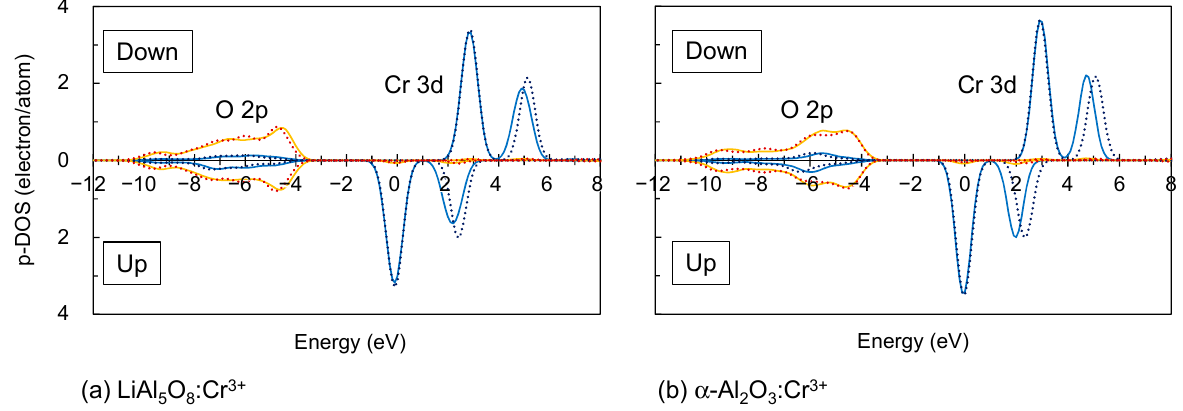
Figure 2. Partial density of states of Cr 3d and O 2p orbitals in ( a ) LiAl 5 O 8 :Cr 3+ and ( b ) α -Al 2 O 3 :Cr 3+ with the HOMO levels set at 0 eV. The profiles were drawn with a Gaussian width of 0.3 eV. Solid line: p-DOSs for the relaxed lattice after MD, dotted line: p-DOSs for the unrelaxed lattice without MD.